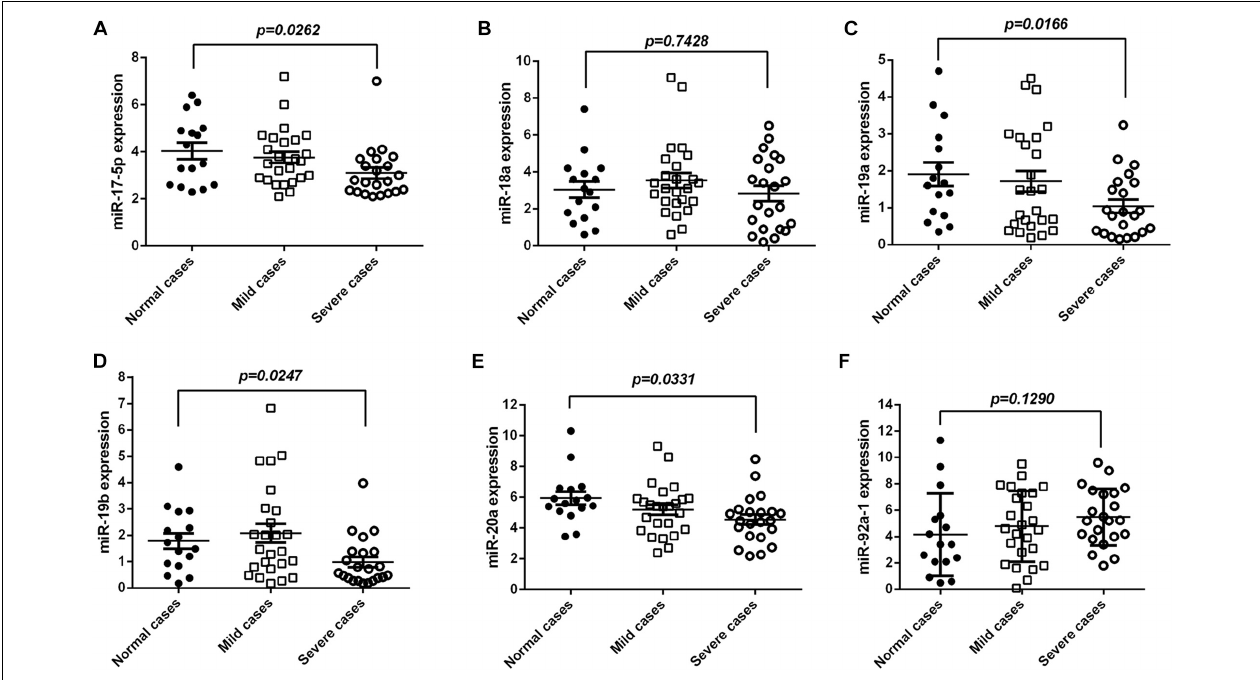
FIGURE 5 | miR-17-92 was reduced in serum of EV71-infected patients. (A–F) The expression levels of mature miR-17-92 in serum specimens of EV71-infected patients by real-time quantitative PCR, and their correlation with disease severity. The EV71-infected patients were divided into a mildly ill group (sample = 25) and a severely ill group (sample = 22) as based on criteria of the Handbook for Treatment of